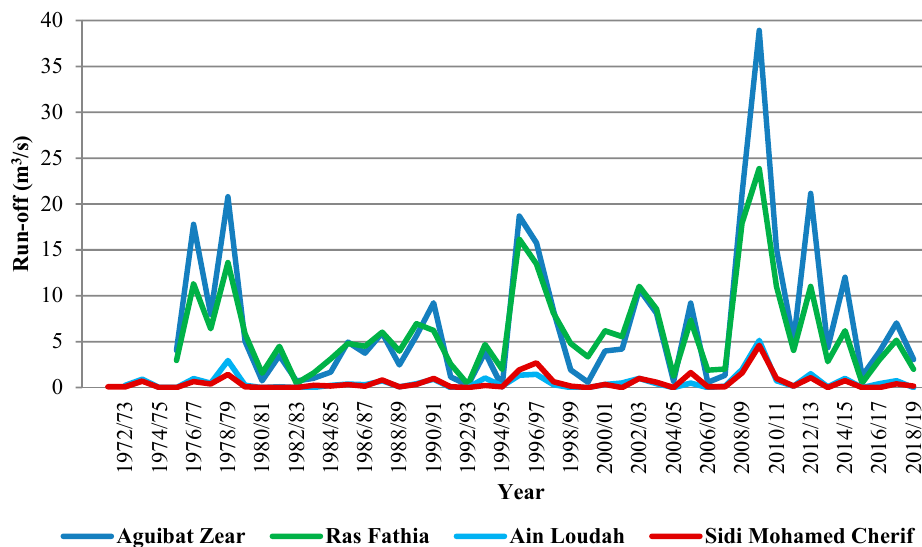
Figure 2. Annual discharges at the 4 hydrological stations studied.